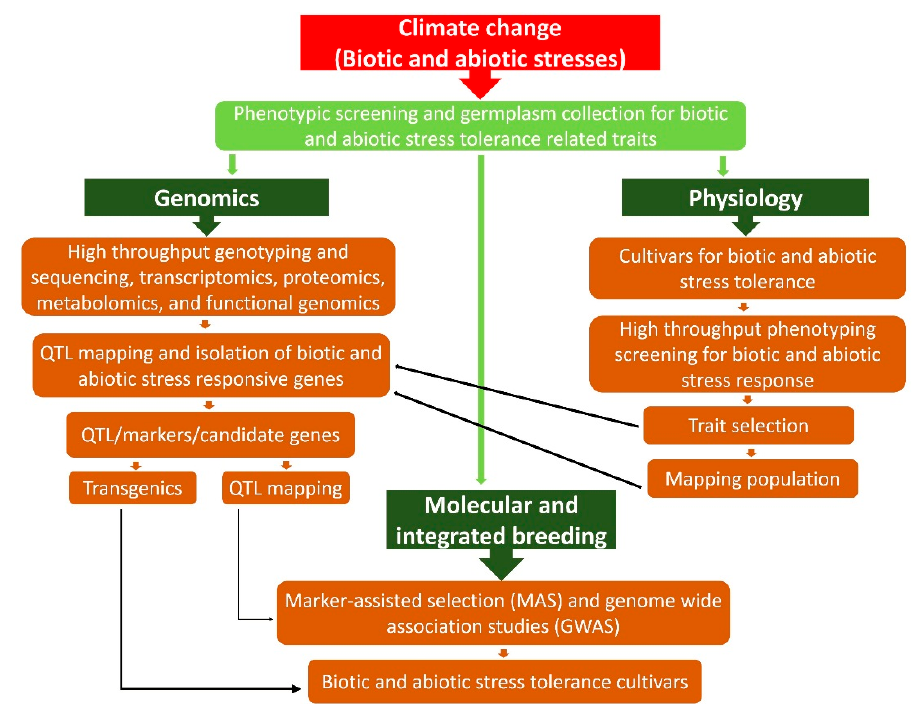
Figure 6. A step-wise presentation of physiological, molecular breeding and genomics approaches to develop biotic and abiotic stress tolerance cultivars.